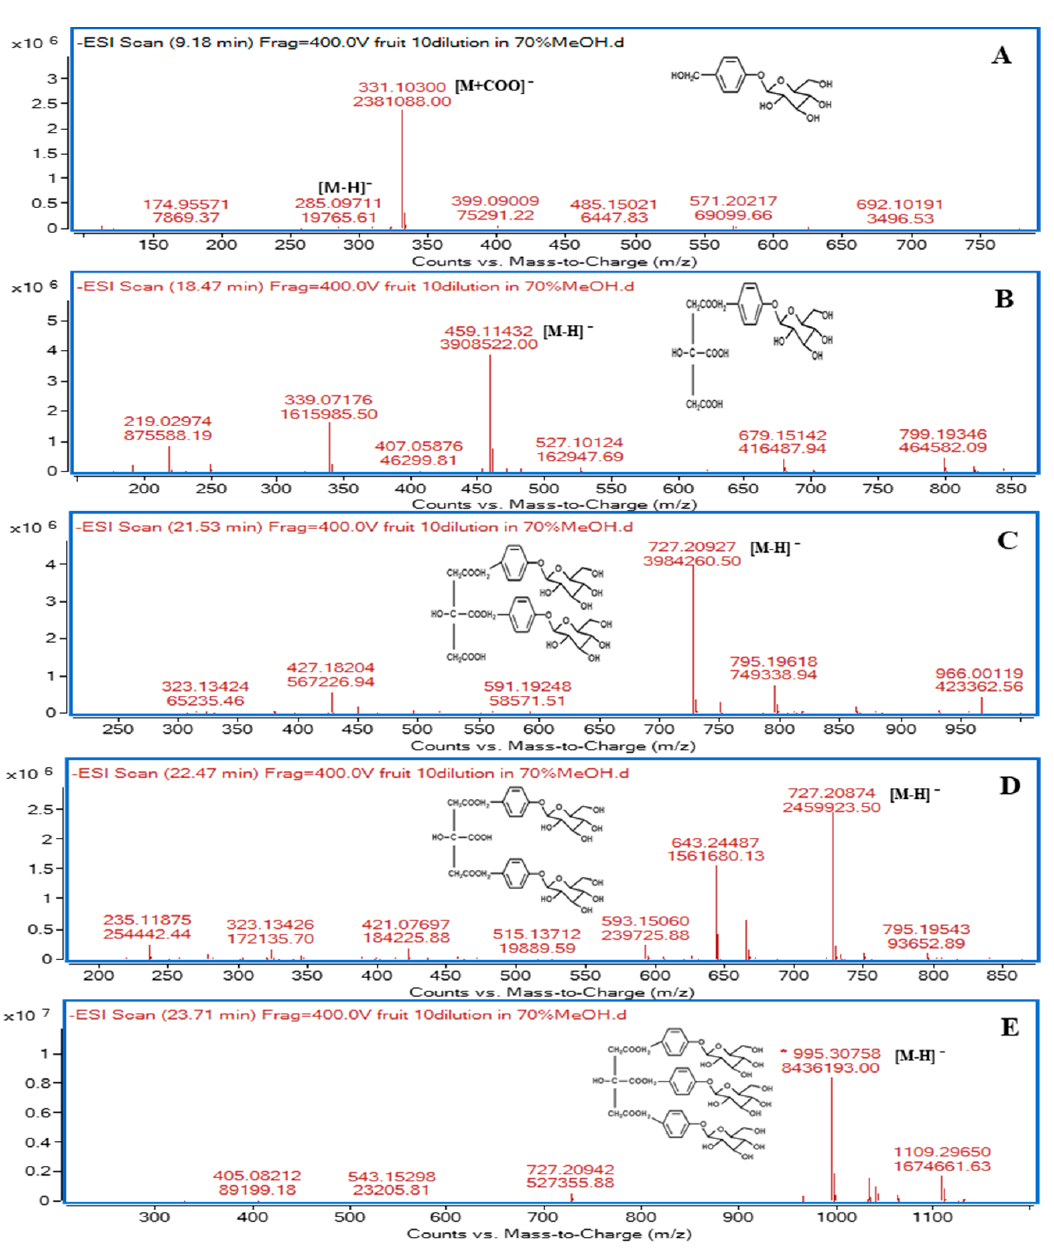
Figure 2. QTOF-MS spectra of parishin derivatives in M. tricuspidata fruit. A , gastrodin; B , parishin E; Figure 2. QTOF ‐ MS spectra of parishin derivatives in M. tricuspidata fruit. A, gastrodin; B, parishin C , parishin B; D , parishin C; E , parishin E; C, parishin B; D, parishin C; E, parishin A.